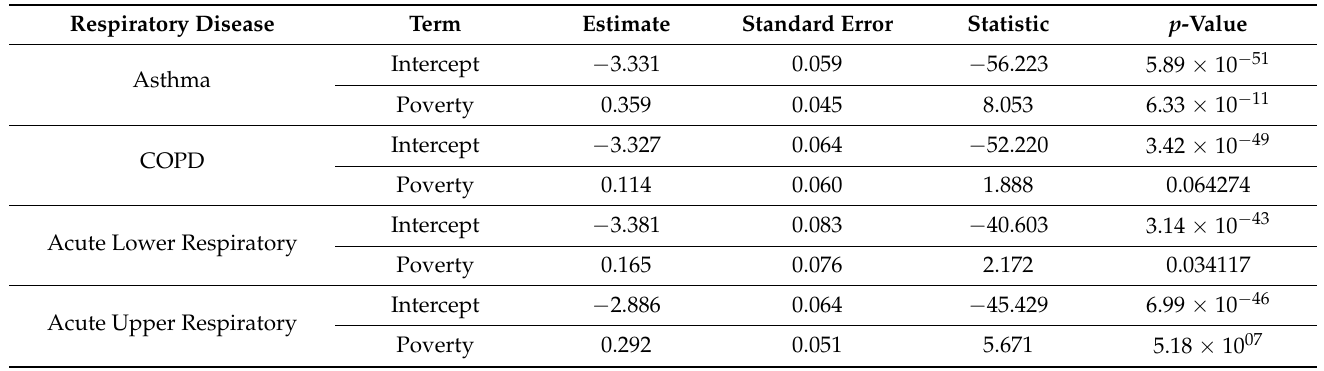
Figure 5. The association between poverty and respiratory diseases. Table 3. The association between poverty and respiratory diseases.